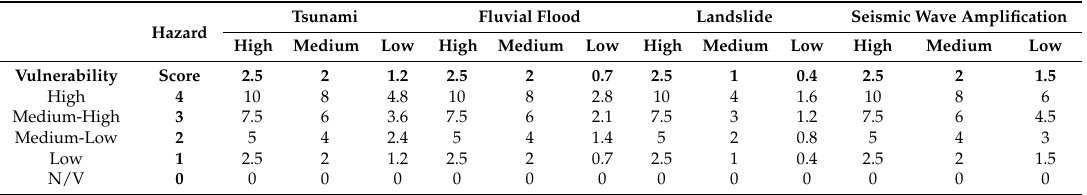
Table 3. Matrix of natural hazards risk scores arisen from the hazard degree and the vulnerability scores.